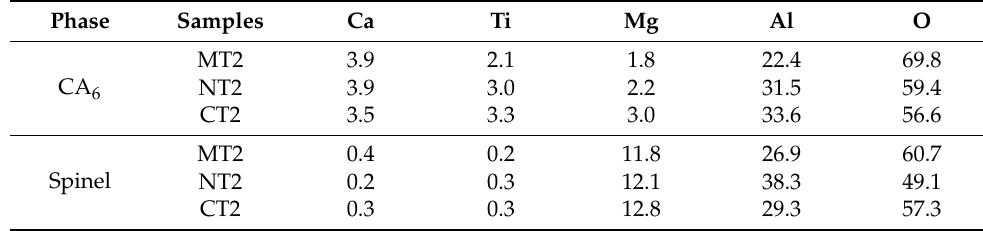
Table 3. EDS analysis of CA 6 and spinel in different samples calcined at 1450 ◦ C for 5 h (at. %).